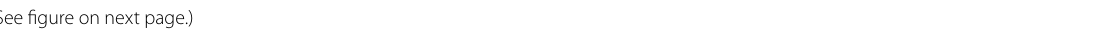
Fig. 3 Serial dependence in the perception of simulated lesions by expert radiologists and untrained observers. A , B In units of shape morph steps, the x ‑axis is the shortest distance along the morph wheel between the current and one‑back simulated lesion, and the y ‑axis is the shortest distance along the morph wheel between the selected match shape and current simulated lesion. Positive x axis values indicate that the one‑back simulated lesion was clockwise on the shape morph wheel relative to the current simulated lesion, and positive y axis values indicate that the current adjusted shape was also clockwise relative to the current simulated lesion. The average of the running averages across observers (blue line) reveals a clear trend in the data, which followed a derivative‑of‑von‑Mises shape (model fit depicted as black solid line; fit on average of running averages). Light‑blue shaded error bars indicate standard error across observers. Lesion perception was attracted toward the morph seen on the previous trial. Importantly, it was tuned for similarity between previous and current morph (feature tuning). C , D The derivative‑of‑von Mises was converted into its source von Mises function ( y ‑axis), and the relative morph difference was plotted in terms of CRD units ( x ‑axis). Violet shaded error bars indicate 95% confidence interval. The curve indicates the proportion of change in response predicted by the change in the sequential stimulus. E , F Bootstrapped half amplitudes of derivative of von Mises fit for 1, 2, and 3 trials back. Half amplitude for 1‑forward is shown as a comparison (grey bars). Each filled dot represents the bootstrapped half amplitude (morph units) for a single observer. Bars indicate the